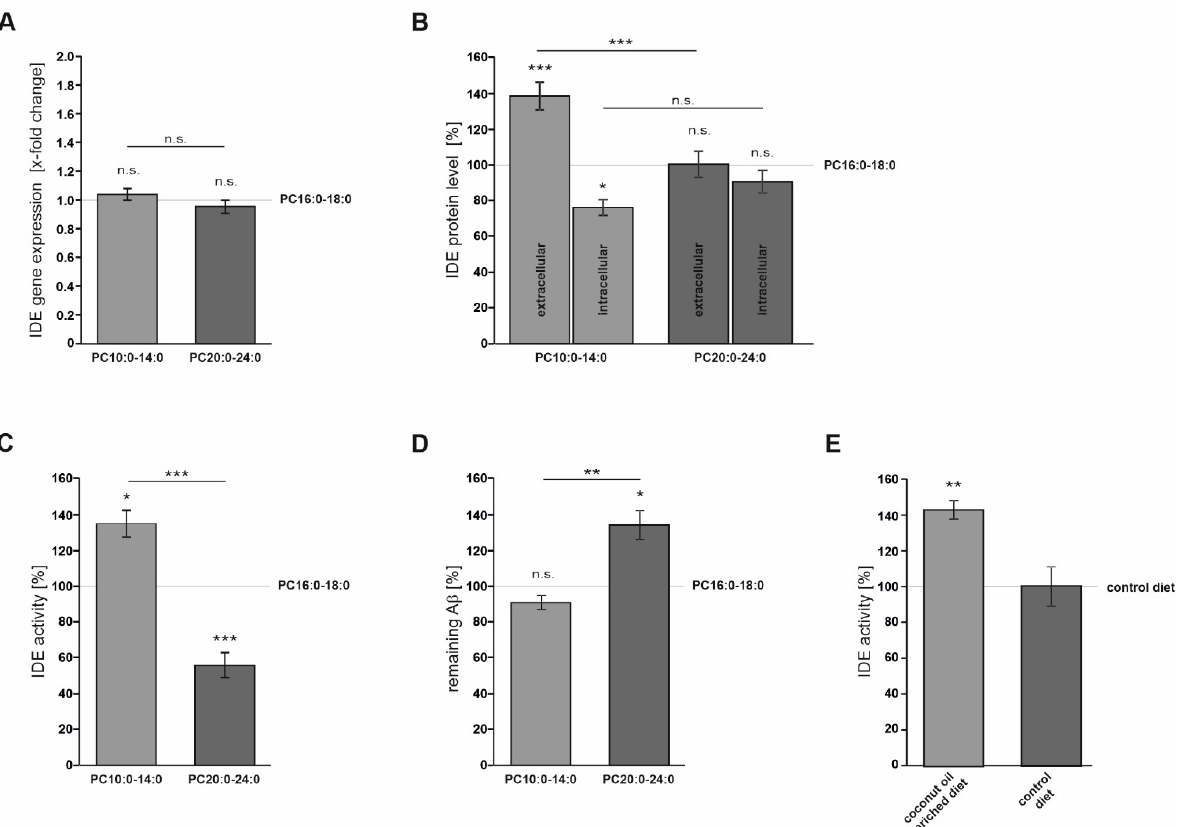
Figure 2. Effect of FA acyl chain length on IDE secretion and catalytic activity. ( A ) Real time PCR analysis of the effect of FA carbon chain length (PC10:0–14:0 and PC20:0–24:0 compared to PC16:0–18:0, respectively) on Ide gene expression in Neuro2a control cells ( n ≥ 11). ( B ) Analysis of the impact of PC10:0–14:0 and PC20:0–24:0 on the cellular sorting of IDE in Neuro2a control cells. Extracellular and intracellular IDE protein levels were examined by Western Blot ( n ≥ 9). ( C , D ) Examination of the direct effect of the FA acyl chain length on the catalytic activity of IDE by using the fluorogenic substrate Mca-RPPGFSAFK(Dnp)-OH ( n ≥ 12) ( C ) or human A β 40 peptides ( n = 5) ( D ). ( E ) Effect of MCFAs on IDE activity investigated in the serum of APPswe/PS1 Δ E9 mice fed with a diet enriched in coconut oil containing high amounts of MCFAs or an isocaloric control diet ( n = 7). Statistical significance was set as * p ≤ 0.05, ** p ≤ 0.01 and *** p ≤ 0.001. n.s.: not